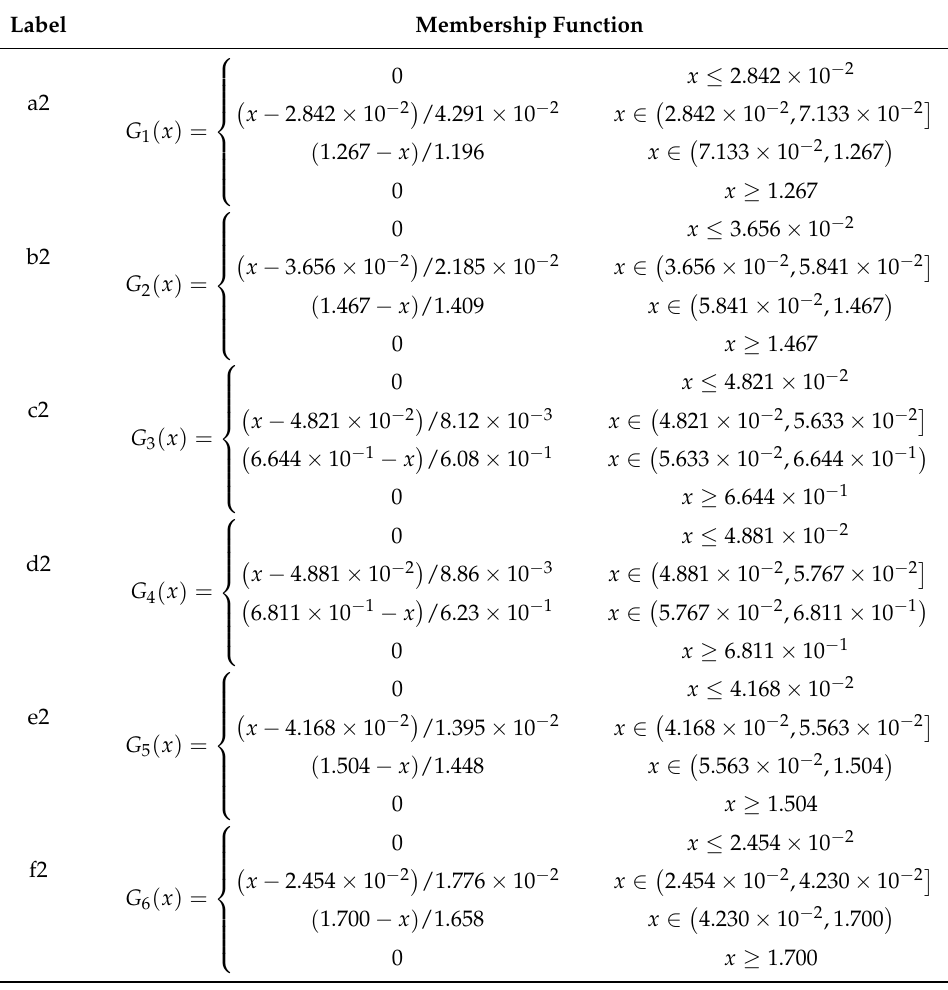
Tables 11 and 12 are the membership function and fuzzy set of the speed regulating valve. Table 11. Membership function of leakage fault in speed regulating valve.